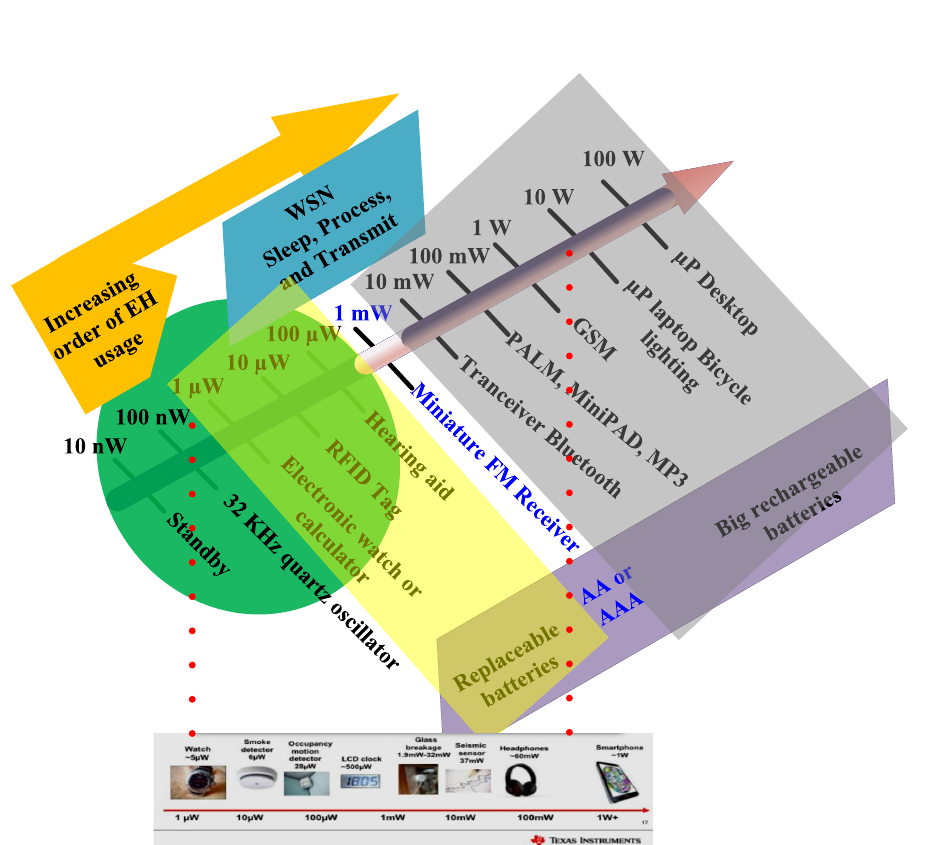
Figure 1. The power requirements of small electronic devices and their future applications